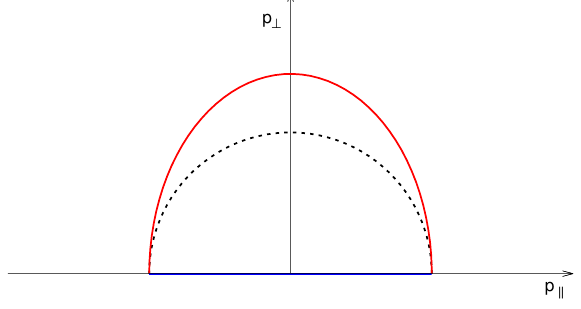
Figure 4. The energy variation process is sketched in the ( p (cid:107) , p ⊥ ) plane for XM in perpendicular propagation. Initially the cold electrons lie on the blue line close to the axis origin. The dashed black curve is the resonant condition γ = n Ω /ω , and the red curve is the final energy given by Eq.